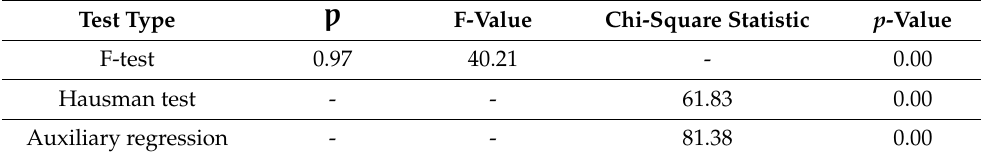
Table 2. Hausman test and F-test results.